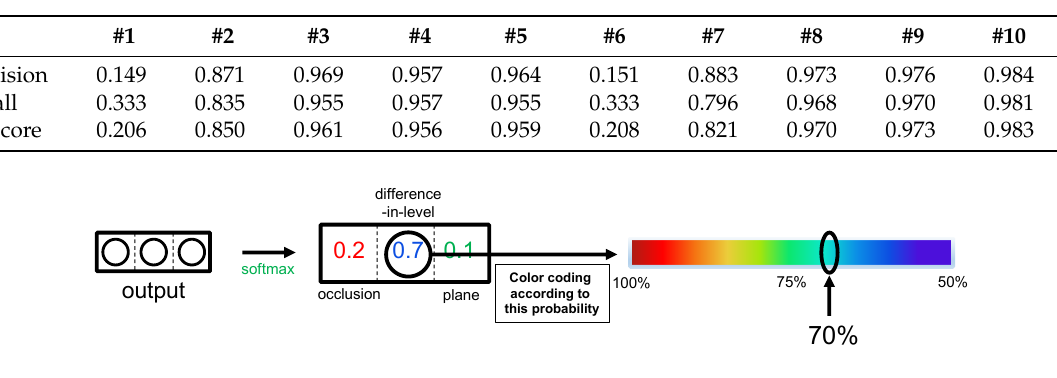
Table 2. Quantitative results where the macro-averaged Precision, Recall, and F1-Score for a test set created by dividing the dataset are shown. The numbers with a # sign correspond to the numbers in Table 1.